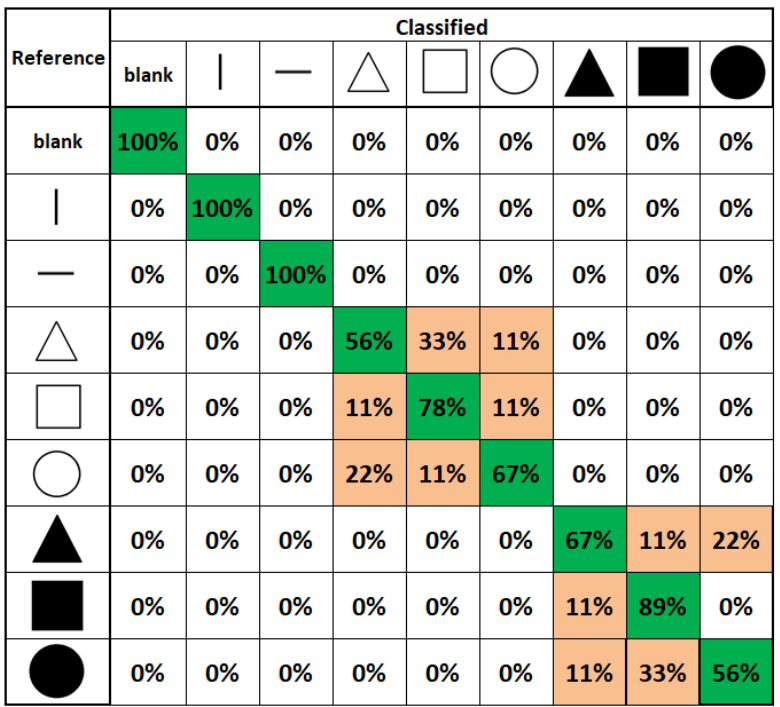
Figure 26. 2D scanning test confusion